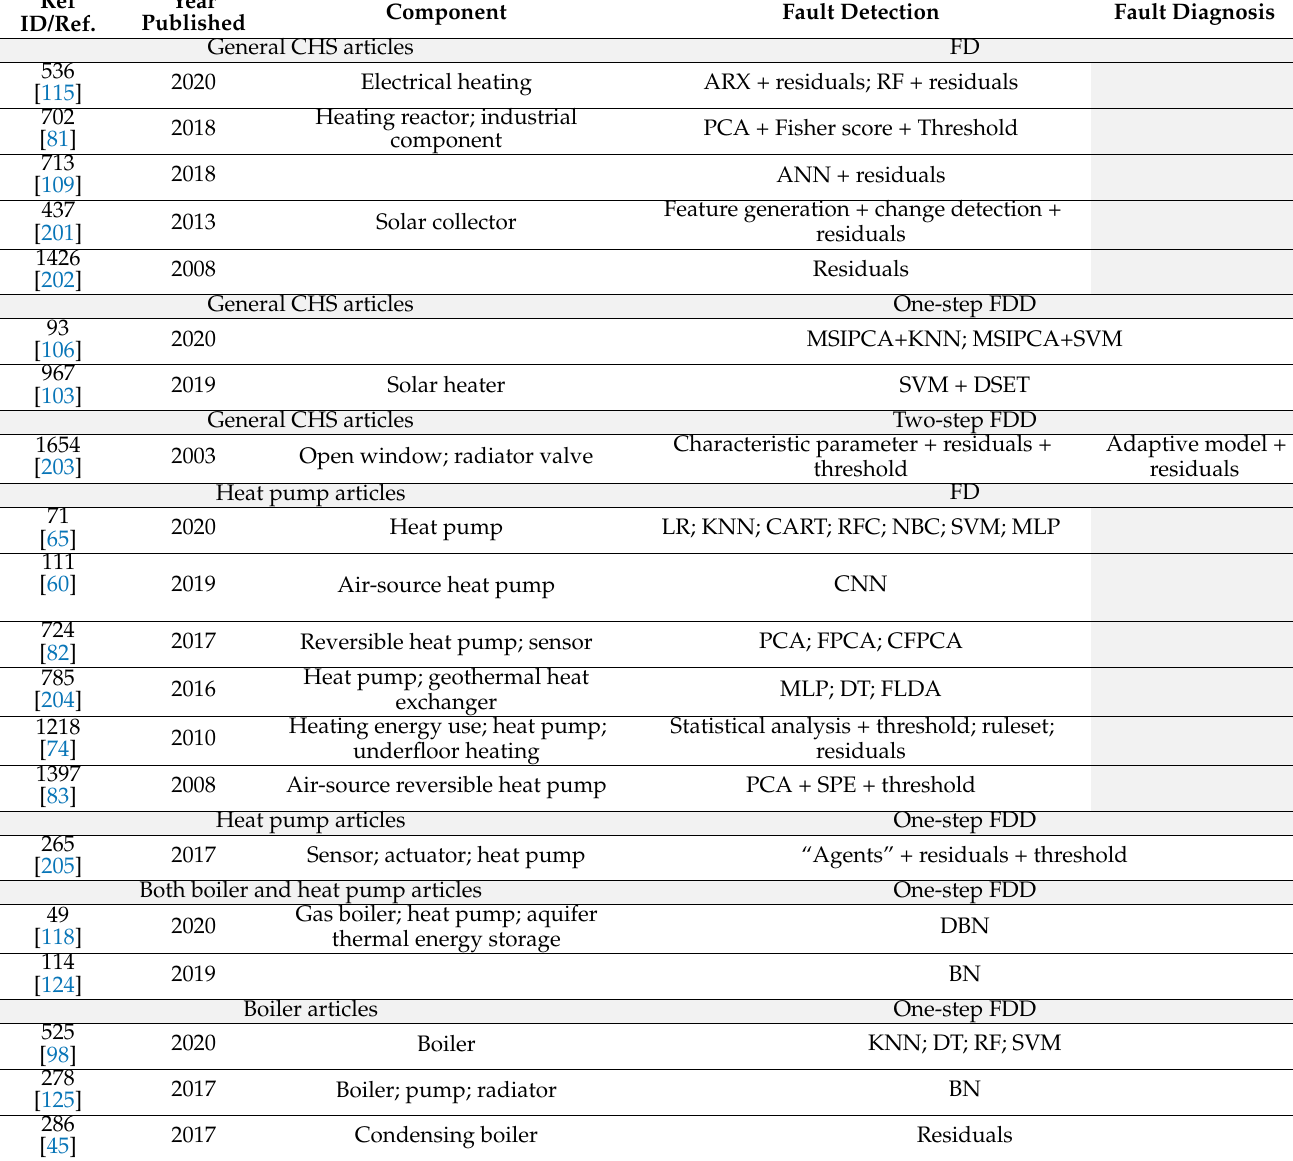
Table A1. Energy conversion: centralized heating